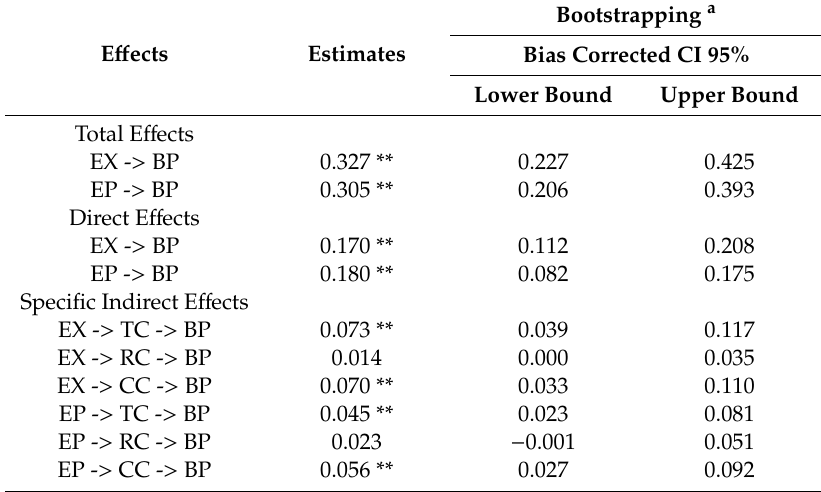
Table 4. Testing of the multiple mediations structural model.